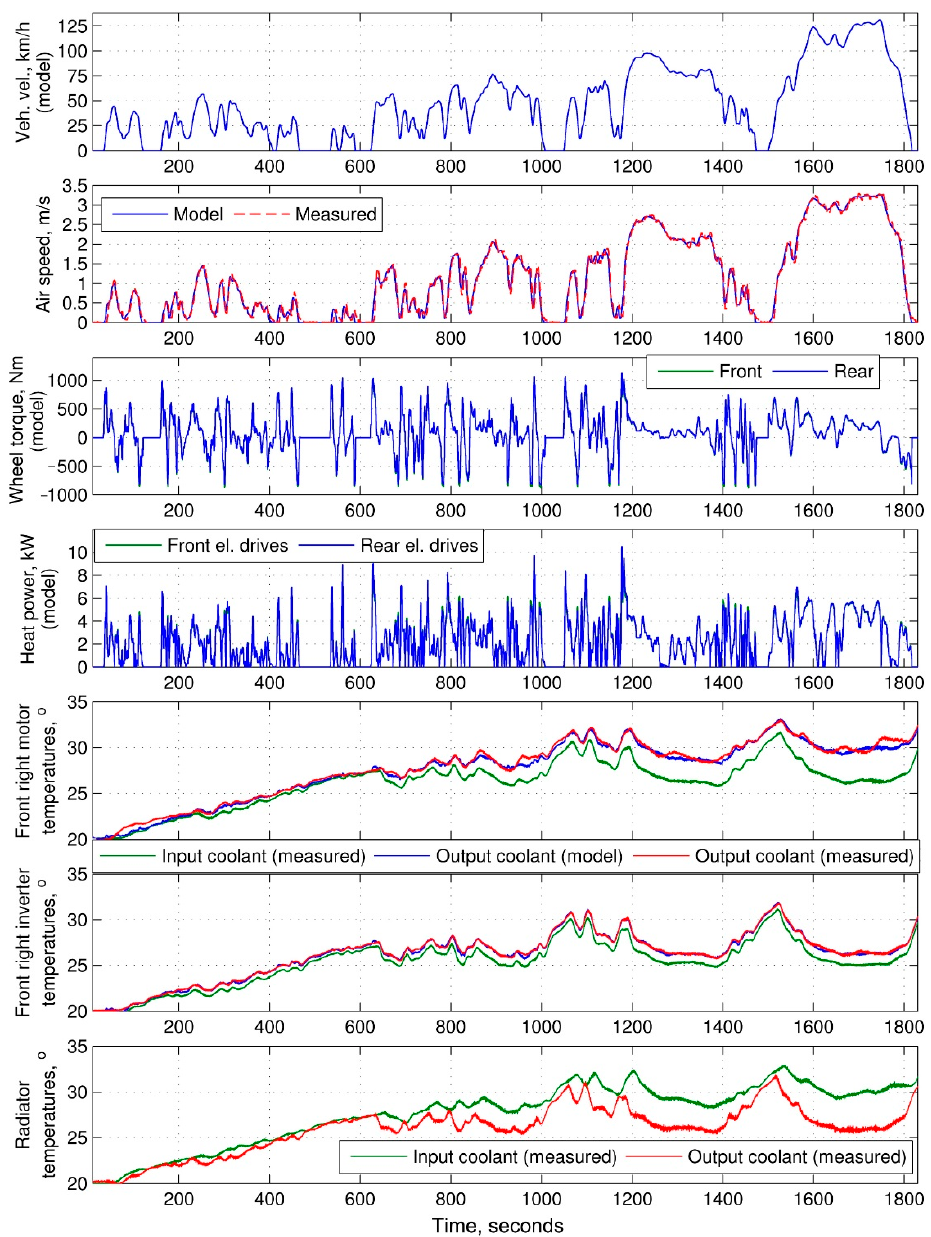
Figure 10. Example of XiL testing results in the World Harmonized Light Vehicles Test Cycle (WLTC) driving cycle.